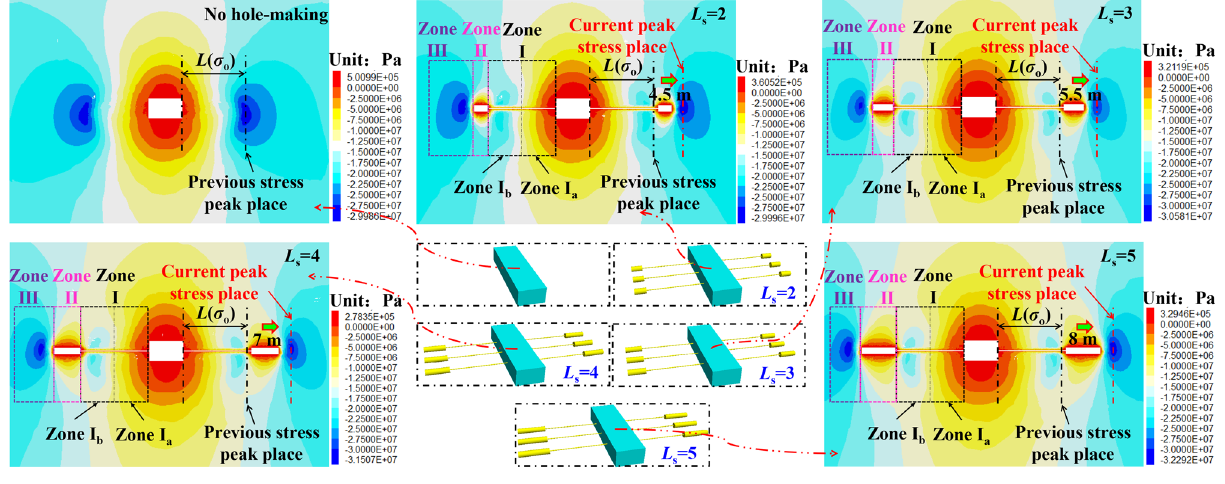
Figure 12. Nephogram of stress distribution of surrounding rock at different L